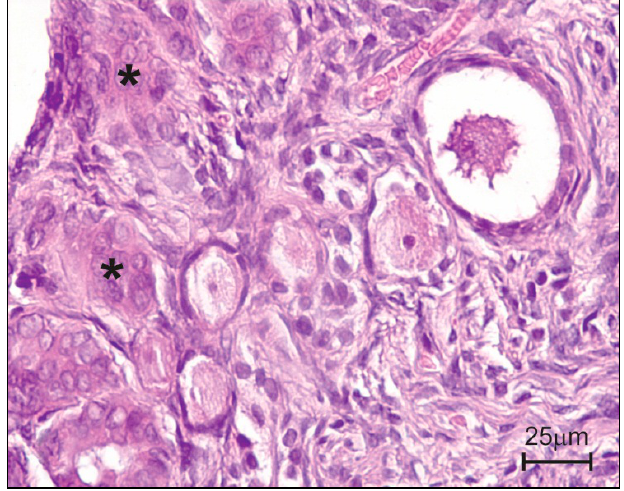
Figure 3. Histological structure after experimental administration of low doses (NOAEL) of ZEN to pre-pubertal bitches [53]. Invaginations of surface epithelium into connective tissue (asterisks).